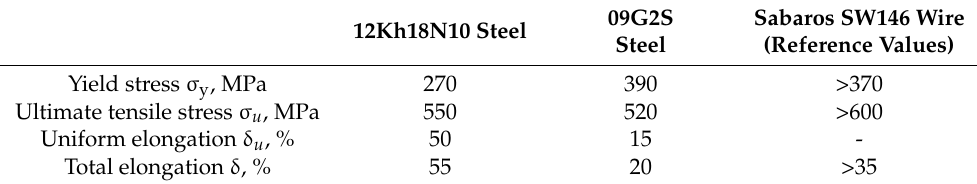
Table 2. Mechanical properties of welded steels and the filler wire.